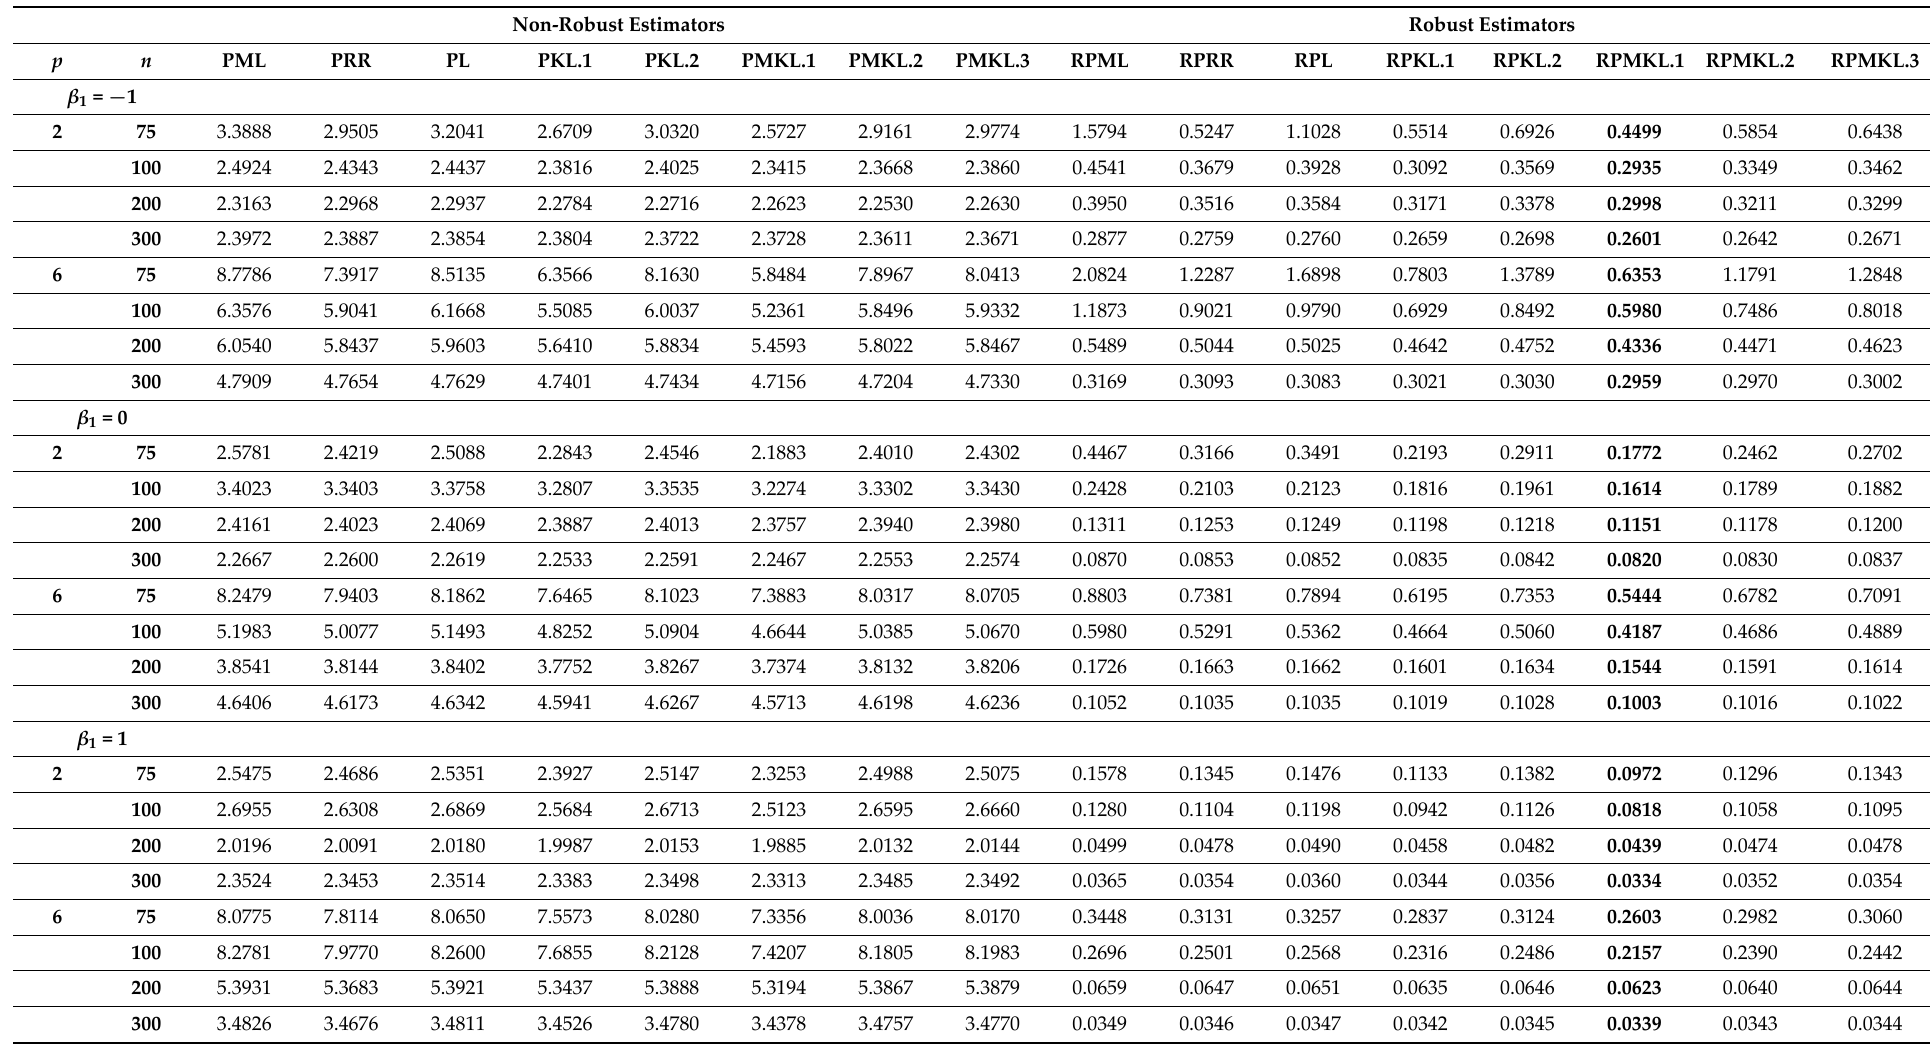
Table A5. AMSE of different estimators when τ = 10% and ρ =